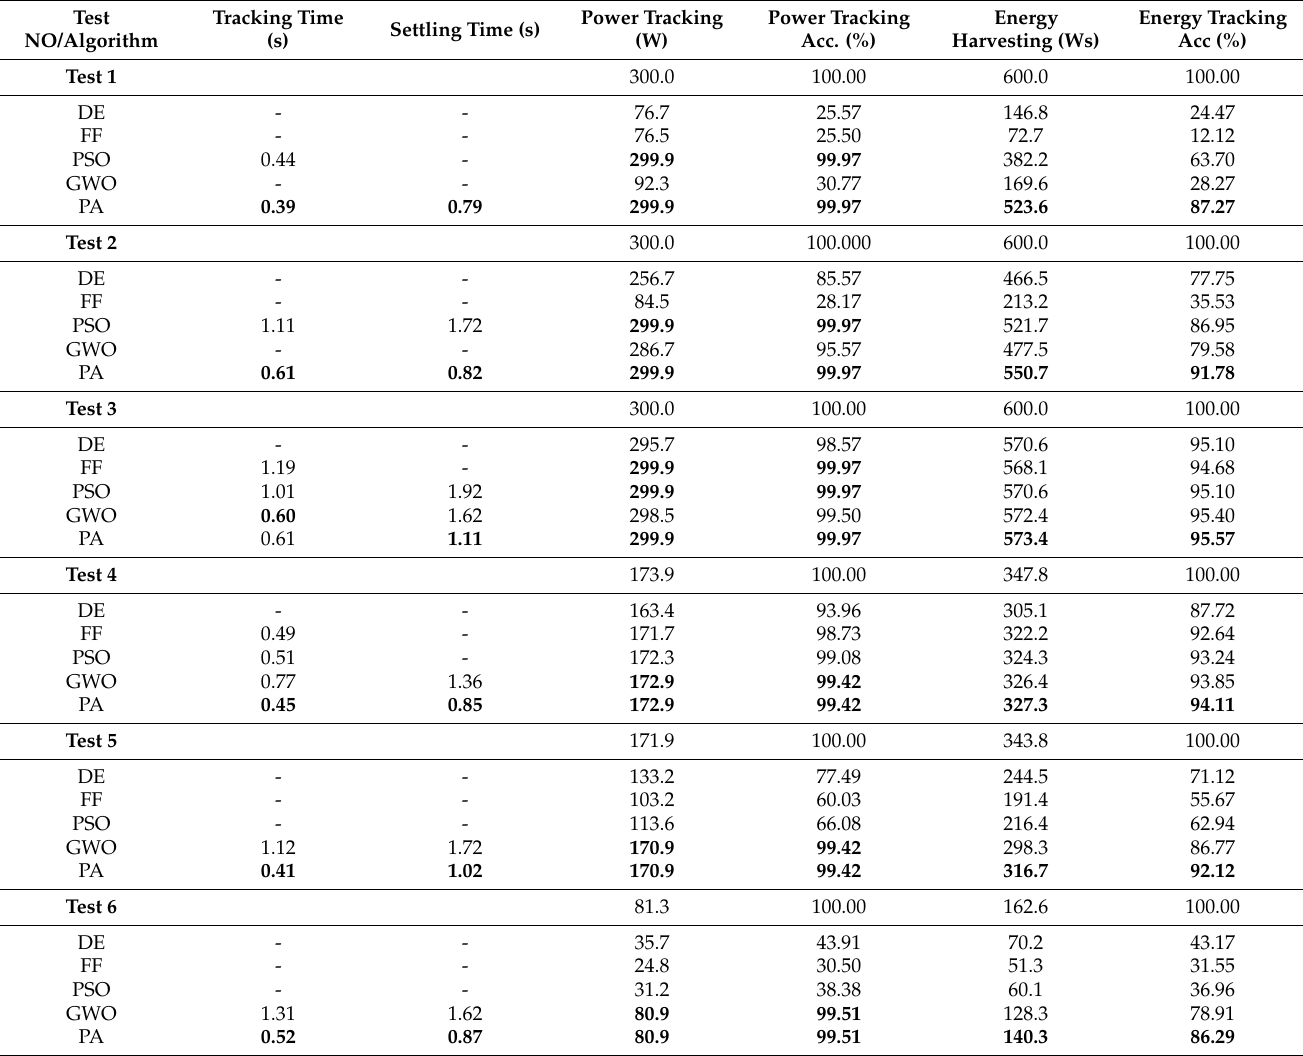
Table 5. Comparison of test